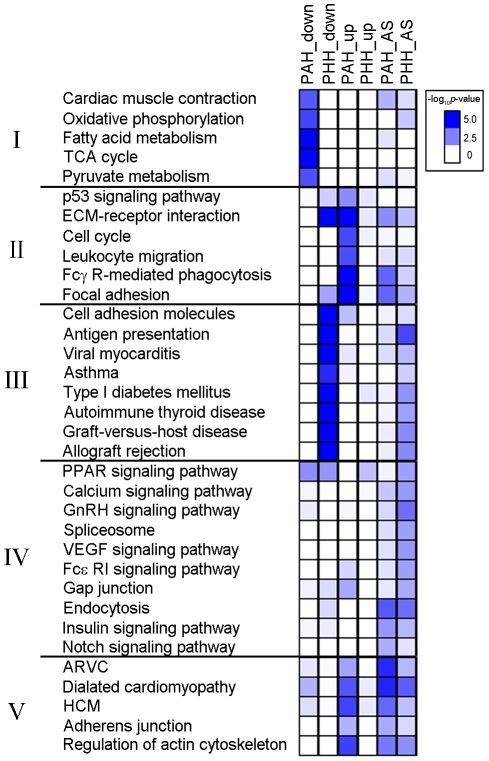
Critical pathways associated with DEGs and exon variants changed in PAH or PHH.Significantly enriched pathways (p<0.05) with at least 5 DEGs or 5 exon variants for PAH and PHH are shown. Color intensity represents degree of enrichment (−log10[p-value]). The significant pathways were categorized. (Group I) pathways for muscle contraction and metabolism. (Group II) pathways mainly for immune and cell cycle. (Group III) pathways for autoimmunity. (Group IV) pathways for cell signaling. (Group V) pathways mainly for cardiac diseases.